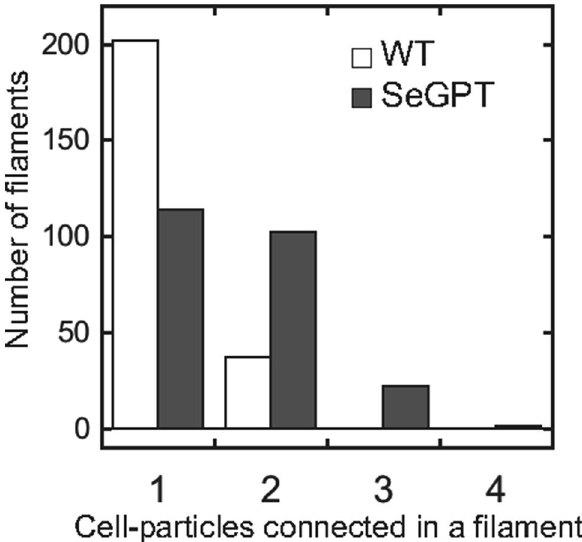
Figure 2. Number of connected cell particles within a filament. Bar graphs shows the number of connected particles (n = 239 for the WT and SeGPT).